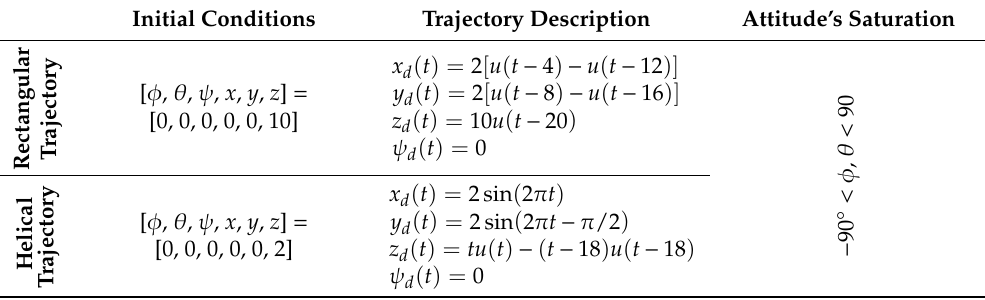
Table 2. Trajectories’ conditions and